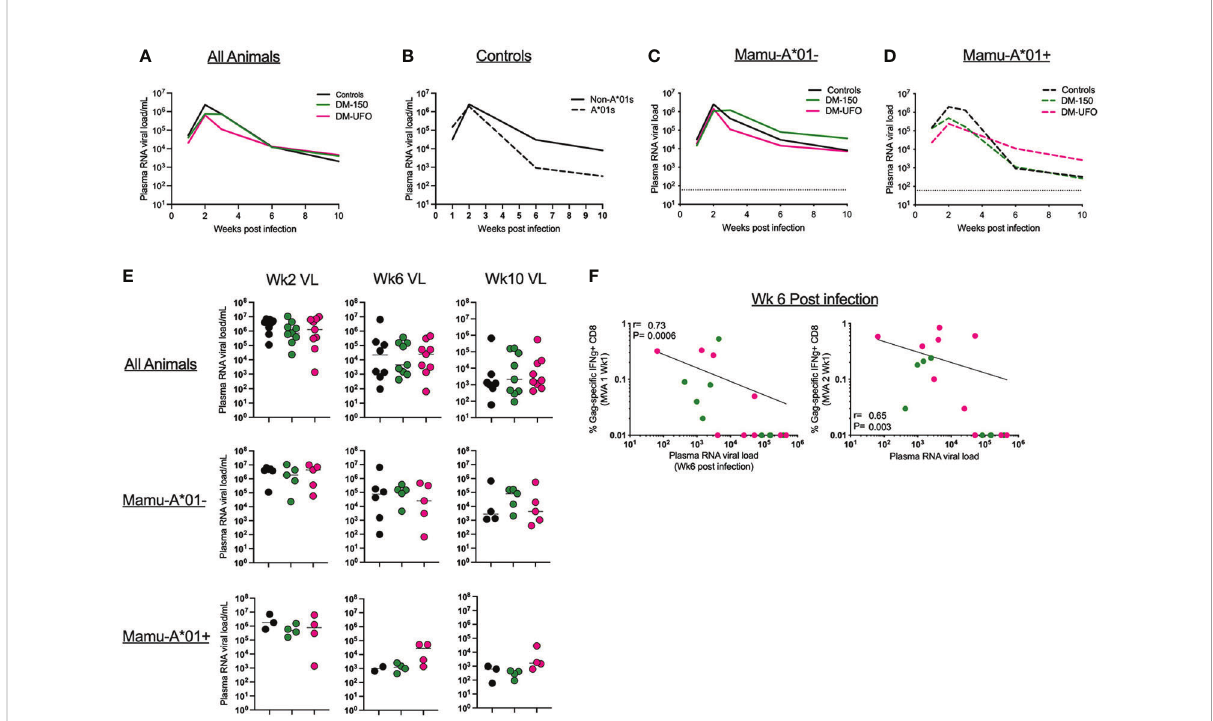
FIGURE 7 (A) Viral load through wk 10 post infection in all controls and vaccinated RMs. (B) Viral load through wk 10 post infection in controls separated by Mamu-A*01 status. (C) Viral load through wk 10 post infection in Mamu-A*01- RMs. (D) Viral load through wk 10 post infection in Mamu- A*01+ RMs. (E) Individual animal data of viral load at wks 2, 6, and 10 post infection. (F) Correlation between wk6 VL and the SIV Gag IFN g + CD8 T cell responses post MVA1 and